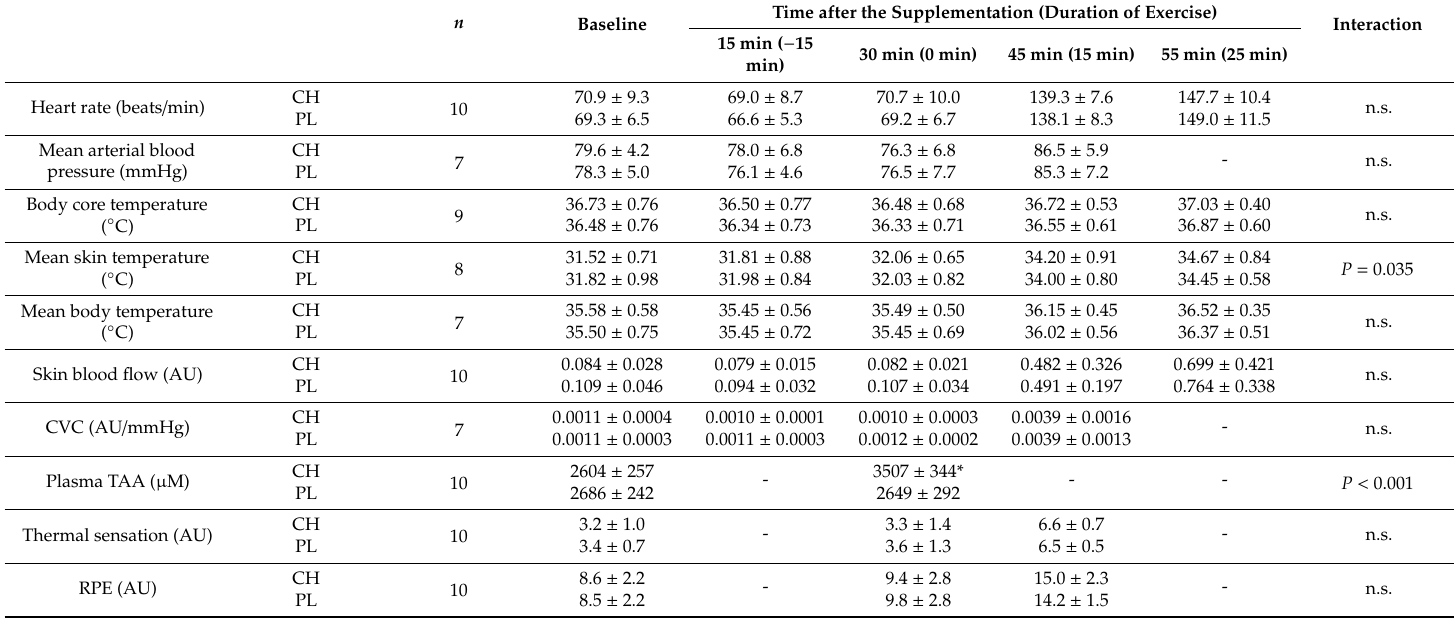
Table 3. Physiological and perceptual responses in the main